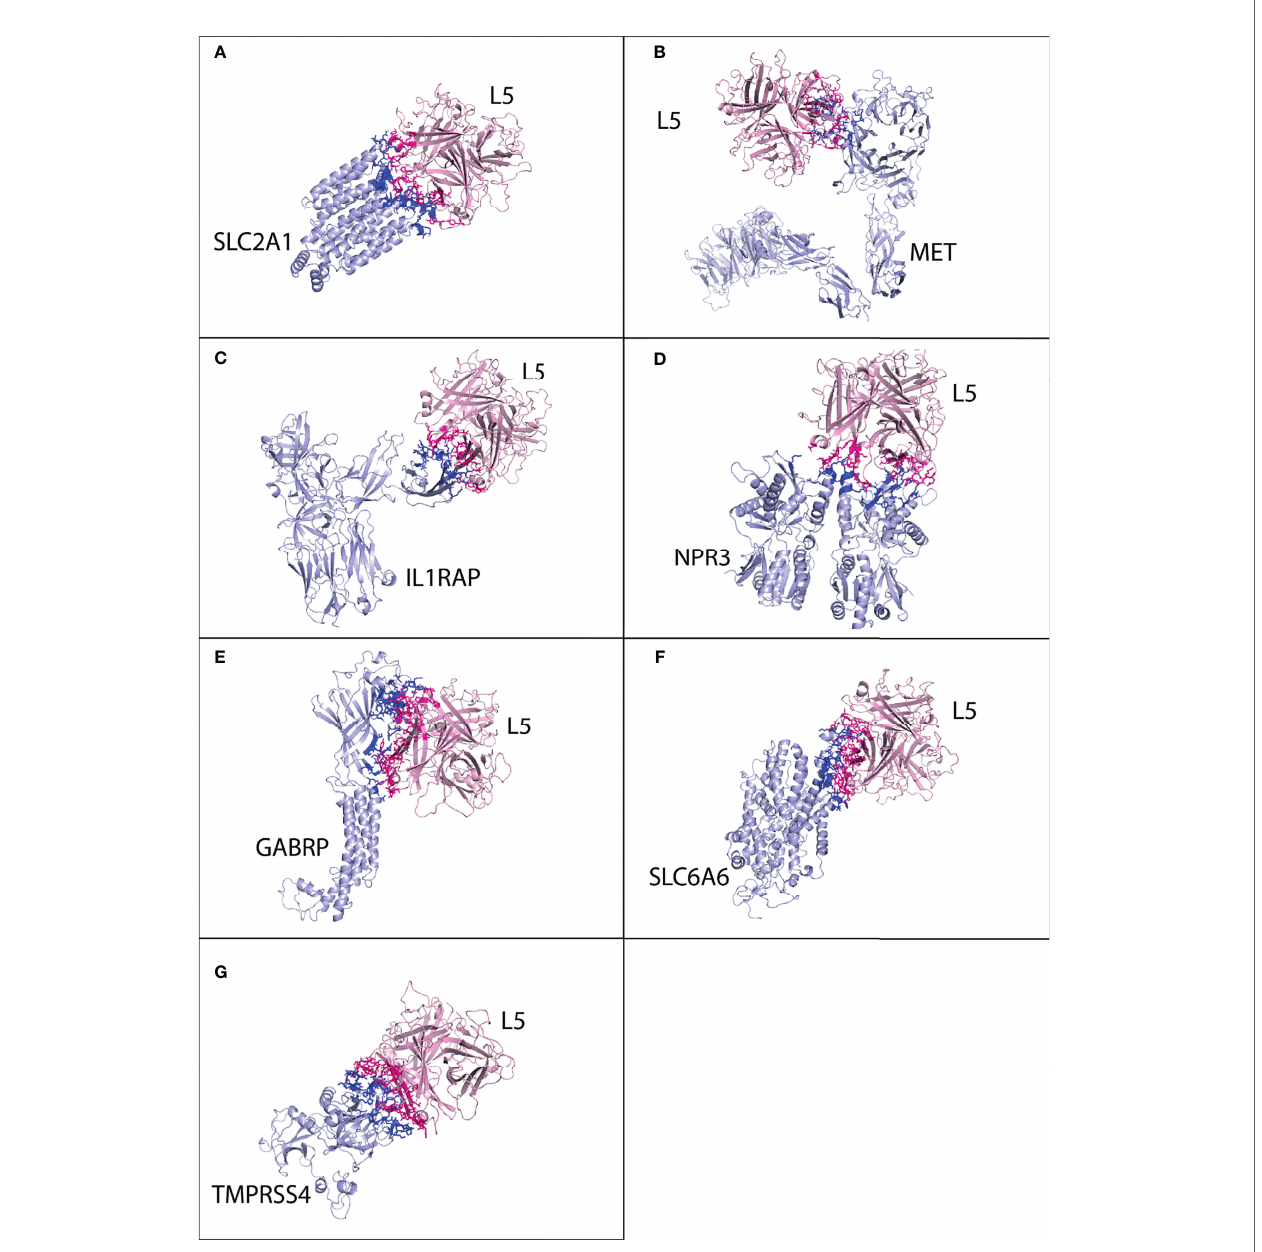
FIGURE 4 | Protein – protein interaction complex of HAdV3 L5 protein with pancreatic cancer receptors. The pink ribbon represents L5 protein, while purple ribbons represent cancer receptors. The interacting residues are shown by a stick, L5 protein is shown in dark pink, and receptor is shown in dark blue. (A) SLC2A1 made a total of 118 interactions. (B) MET made 73 interactions. (C) IL1RAP made 62 interactions. (D) NPR3 made 92 interactions. (E) GABRP made 168 interactions. (F) SLC6A6 made 147 interactions. (G) TMPRSS4 made 128